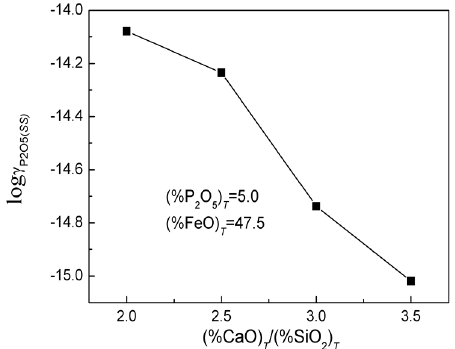
Figure 10. Effect of binary basicity in the initial slag on γ P